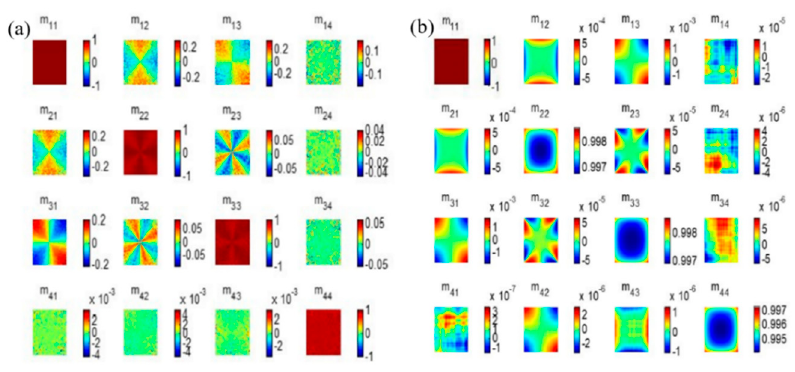
Figure 3. The calculated: EMM ( a ); and SEMM ( b ).